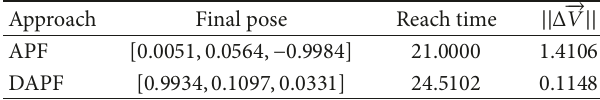
Table 3: Results of scenario 1.